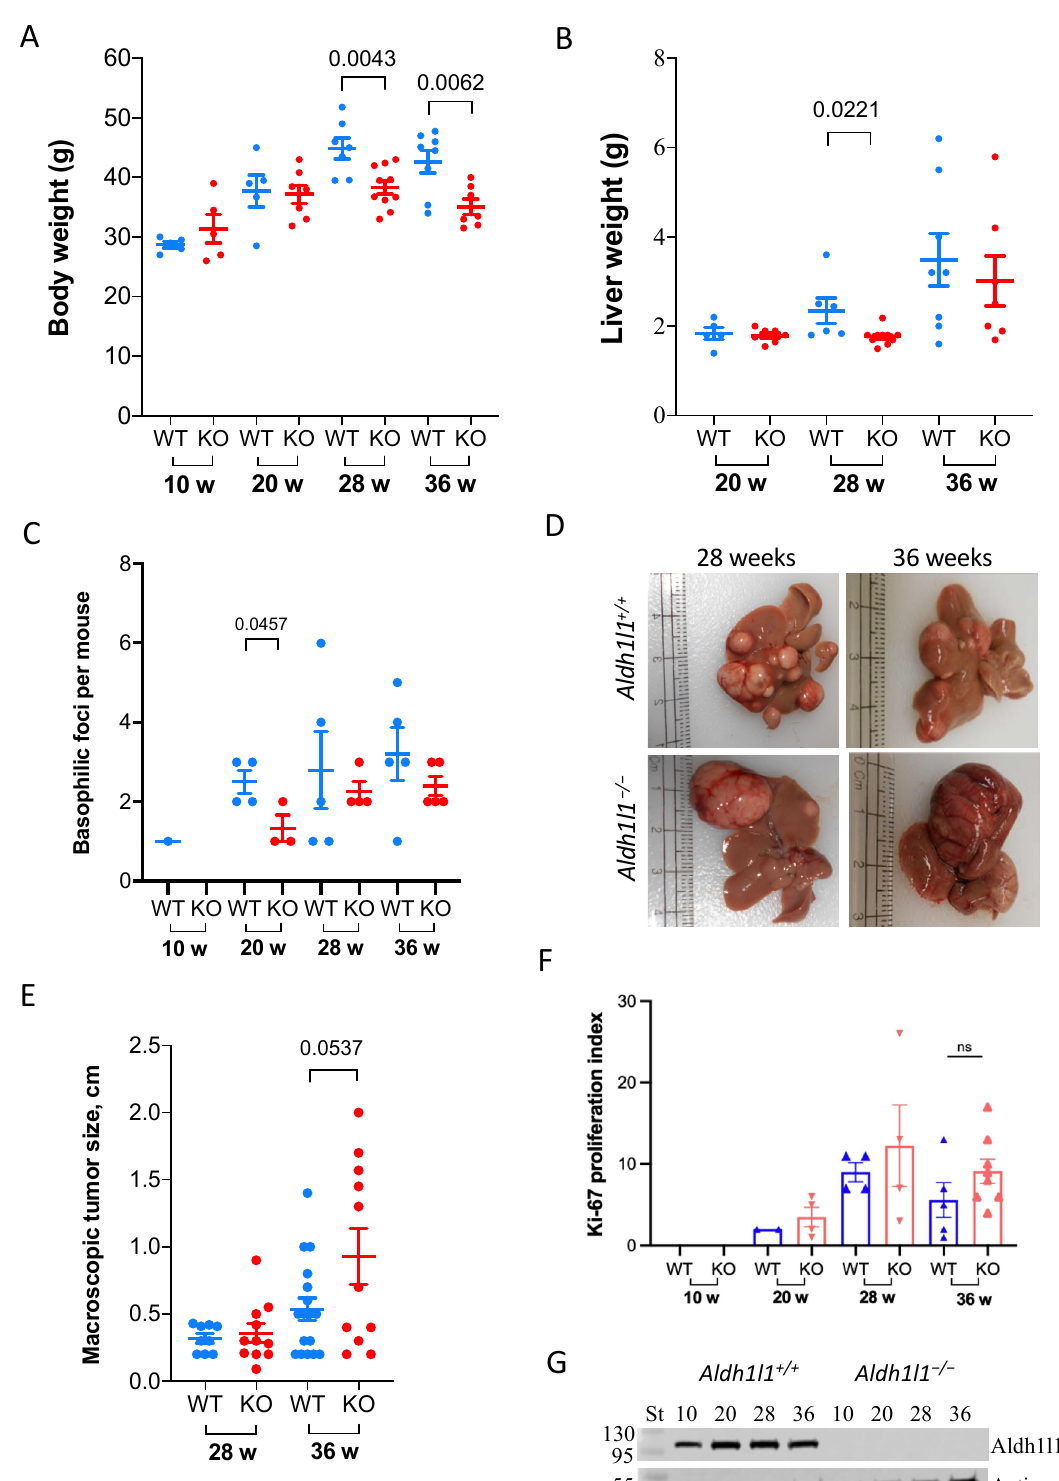
Figure 1. Comparison of WT and Aldh1l1 KO mice after DEN injection. Mouse body ( A ) and liver ( B ) weight. ( C ) Number of basophilic foci from microscopic evaluation of liver tissue cross-sections. ( D ) Representative liver images of DEN-treated mice (macroscopic tumors are clearly visible as large lesions on the surface). ( E ) Sizes of macroscopic tumors in each animal group. ( F ) Ki-67 proliferation index calculated from immunostaining (as described in Materials and Methods, Section 2.5). ns: Not significant ( G ) Levels of ALDH1L1 protein in the liver at different time points post-DEN treatment (Western blot assay with ALDH1L1-specific antibody; 20 µ g of total protein was used for each sample; actin is shown as loading